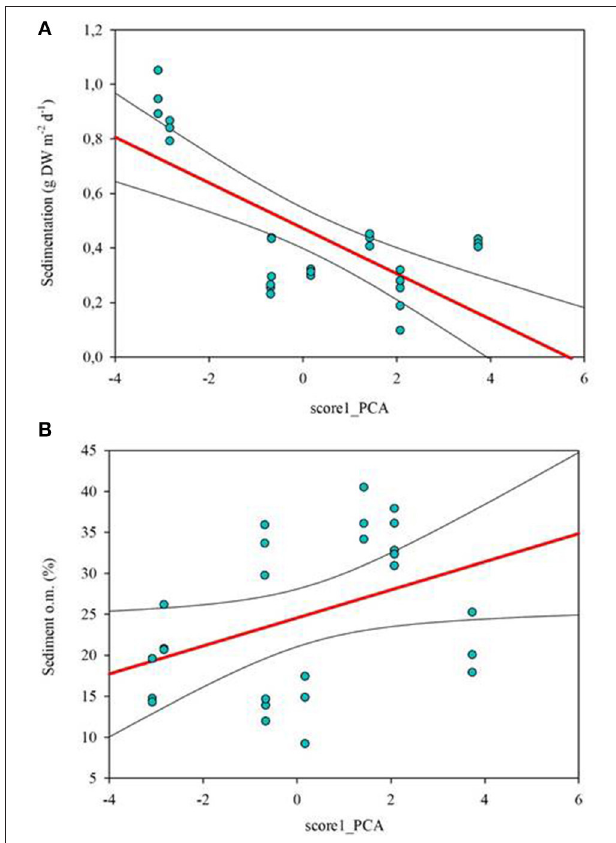
FIGURE 4 | Correlations between physicochemical variation of the water column measured by PC1 score from Figure 3 and sedimentation rates [g dry weight (DW) m − 2 d − 1 ; (A)] and sediment organic content (in %; B ). PC1 explained 39.9% of the variability of the samples and it was mainly accounted by sub-superficial percentage of light in the meadow (Im), water column Chl-a (W_Chl-a) and total phosphorus. Correlations are given as Spearman’s rank-order correlations (rho) in Table 3 . Significant values are set at p < 0.05.